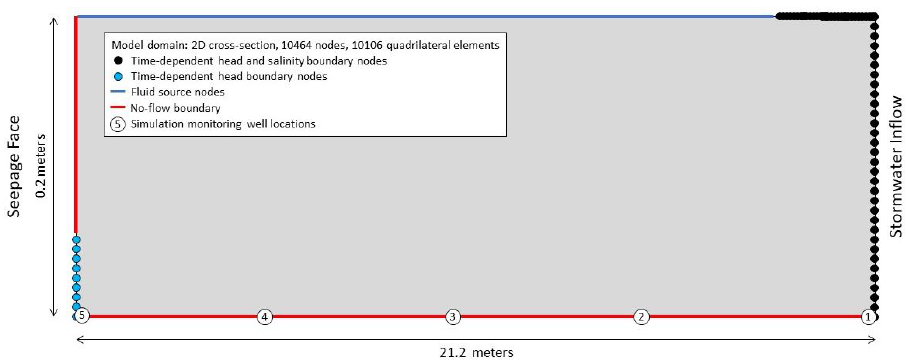
Figure 6. Model domain used in the flow and solute transport models. The flow enters on the right side of the figure, represented by black circles, and moves through the wetland to the seepage face in the left bottom corner, indicated by blue circles. The no-flow boundary (red line) represents the concrete culvert.